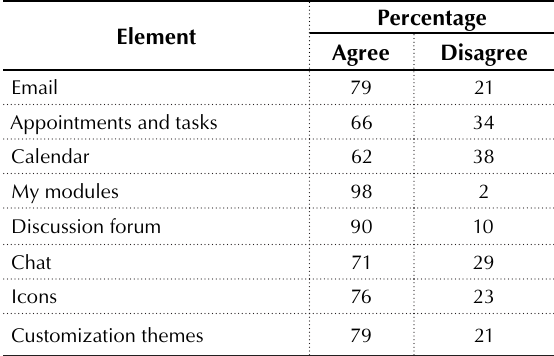
Table 3. Percentage (rounded) frequency scores